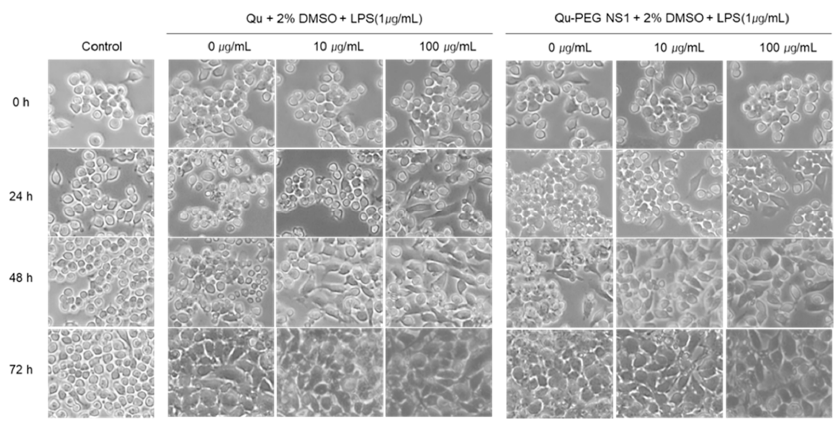
Figure 9. The morphological changes in LPS-induced RAW 264.7 cells treated with Qu and Qu-PEG NS. The RAW 264.7 cells were incubated with Qu or Qu-PEG NS for 24 h (24 h) and then LPS was added and grown (48 h and 72 h). Phase contrast microscopy was used to capture the images of RAW 264.7 (150 ×